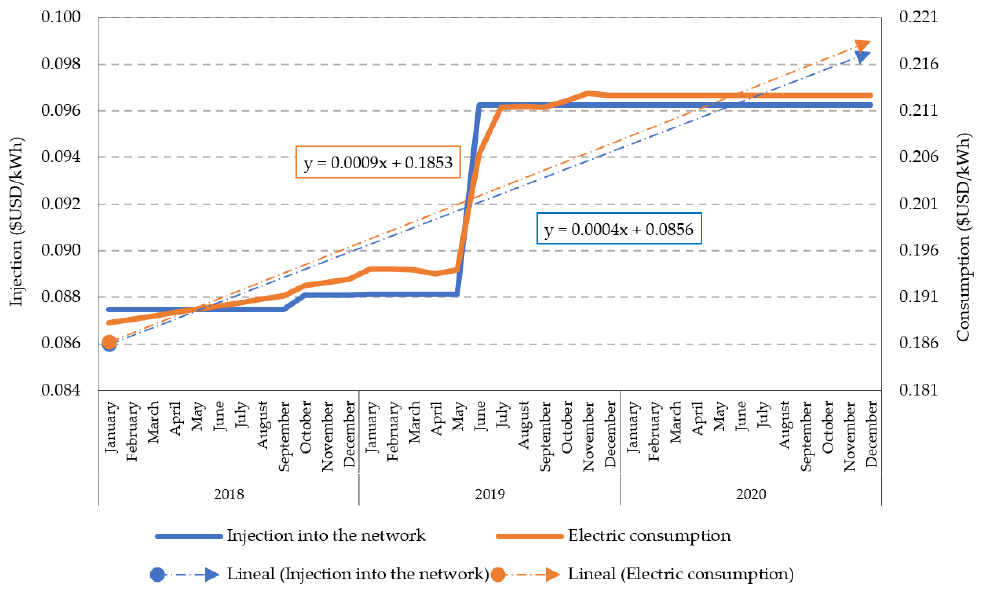
Figure 12. Electric energy consumption and injection to the network tariffs of Arica for 2018–2021. These rates are present on the official site of the distribution company CGE, where they are broken down into various items. Source: Adapted from [43].